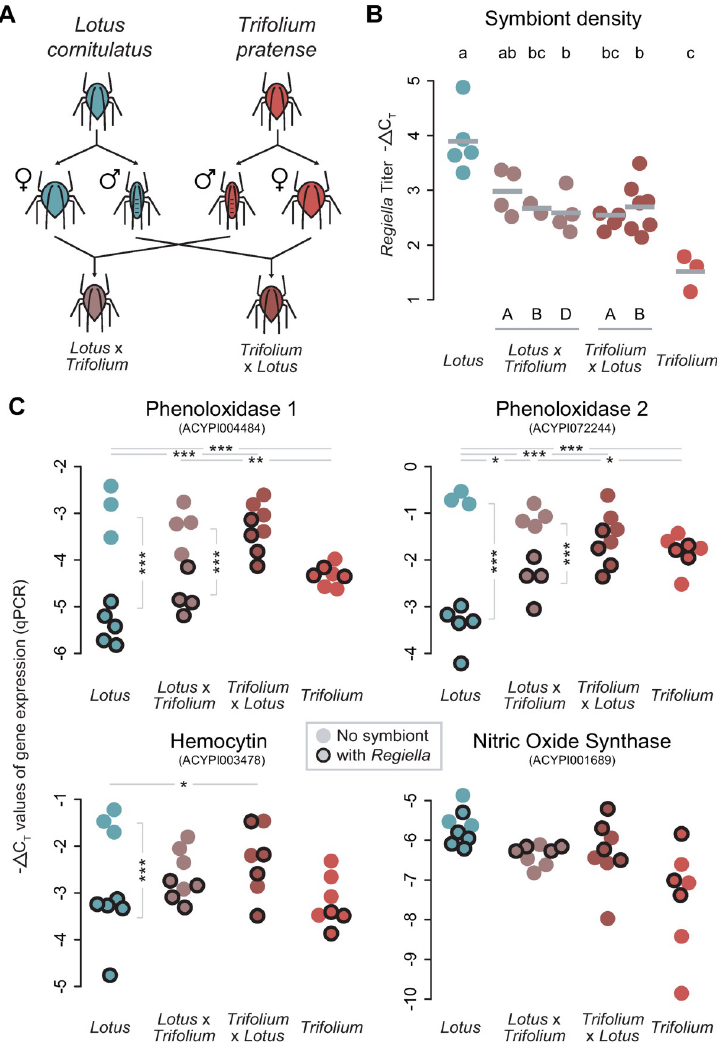
Fig 4. Regiella density and immune gene expression in F1 hybrid lines. A: Diagram of the crossing scheme. B: Regiella density in parental and F1 lines. The y-axis shows the - Δ C T values reflecting Regiella density, which can be interpreted on a log 2 scale. The genotypes are shown along the bottom of the figure; the letters represent different replicate lines of each direction of the F1 cross. Each biological replicate, representing an independently injected aphid + Regiella line, is shown by a colored point, with the means for each genotype shown with grey bars. Significance groups (ANOVA & Tukey’s HSD post-hoc analysis) are shown along the top of the figure at p < 0.05. C: Immune gene expression in lines with and without Regiella . The y-axis of each plot shows - Δ C T values (qPCR output) of gene expression. Aphid genotype is shown along the bottom of each figure. Each biological replicate (an independently injected line) is shown by a colored point, with lines harboring Regiella indicated by a dark black outline as indicated in the legend. Statistical significance (2-way ANOVA & post-hoc analysis) is shown with light grey lines: at the top of the figures, the interaction term between Regiella presence/absence and host genotype is indicated with an � , �� , or ��� indicating that two genotypes differ in the extent to which Regiella altered gene expression at p < 0.05, p < 0.01, or p < 0.001, respectively. Within genotypes, whether Regiella significantly altered gene expression is shown with a vertical grey bracket. expression in the Trifolium genotype (post-hoc tests S4 Table and Fig 4C). Further, the F1 lines showed significant differences in gene expression that were intermediate to the two parental lines: three immune genes were downregulated in response to Regiella , but to a signif- icantly lesser extent than in the Lotus genotype (post-hoc tests S4 Table and Fig 4C).